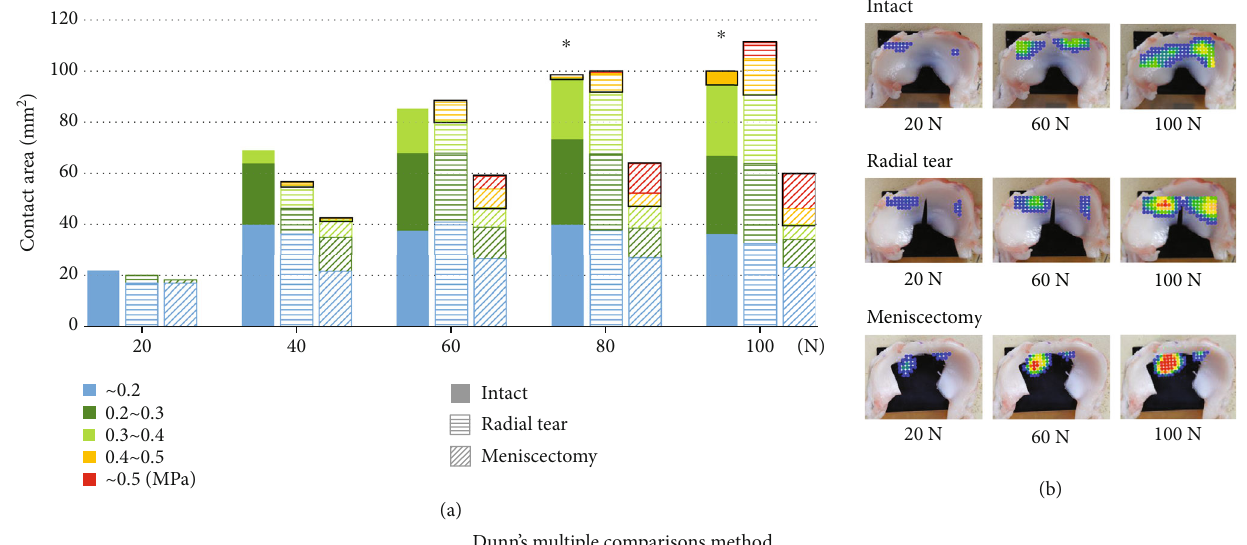
Figure 6: (a) Area analysis results for each pressure region for every 20N. Areas above 0.4MPa are indicated by squares. ∗ P < 0 : 05 : radial tear and meniscectomy compared to intact in the area of ≥ 0.4MPa. (b) Color map of typical pressure distribution under 20, 60, and 100N